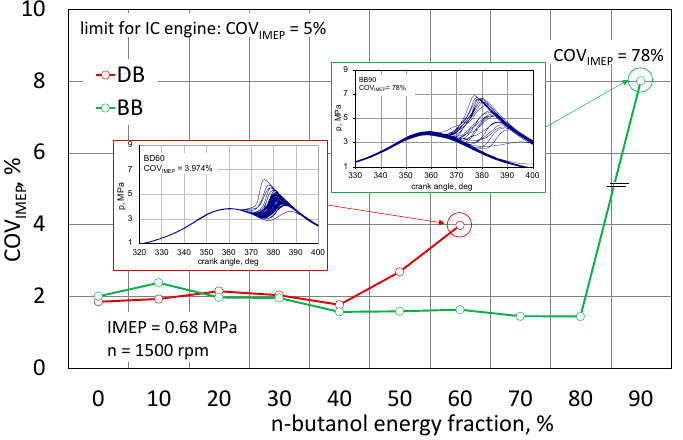
n‐butanol energy fraction, Figure 8. Uniqueness of IMEP. Figure 8. Uniqueness of IMEP. For both analyzed cases, up to 40% of the energy content of n-butanol, the COV IMEP index was at the same level of approximately 2%, i.e., the engine performance was stable. After exceeding this share for the DB mixture, the IMEP uniqueness began to increase, reaching the value of 4% for DB60. This is not exceeding the permissible limit, but above this proportion of n-butanol, the engine clearly had problems with the spontaneous com- bustion of the mixture. In an engine powered by a mixture with RME biodiesel, up to 80% of n-butanol content, the COV IMEP index remained constant below 2%, only exceeding this limit of n-butanol content practically prevented the engine from working. The assessment of the engine operation stability based only on COV IMEP does not provide full